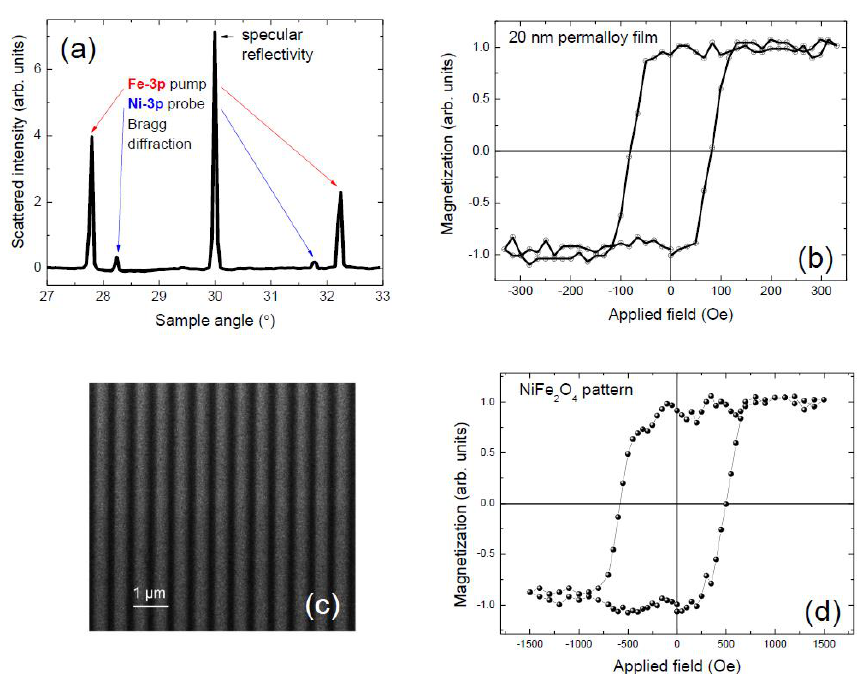
Figure 3. Permalloy and Ni-ferrite samples. ( a ) Rocking scan of the Py grating sample, showing the Bragg peaks corresponding to the Fe-3p resonant pump and to the Ni-3p resonant probe FEL beams; ( b ) Hysteresis loop of the Py magnetization measured by magneto-optical Kerr effect (MOKE), with the magnetic field applied parallel to the grating lines; ( c ) Scanning electron microscopy image of the Ni-ferrite sample. An area of 100 × 400 µm 2 is patterned into a ~600 nm period grating by focused ion beam etching; ( d ) Field dependence of the FEL radiation intensity diffracted at the Fe-3p resonance, measuring the magnetic response over the ruled area of the Ni-ferrite.